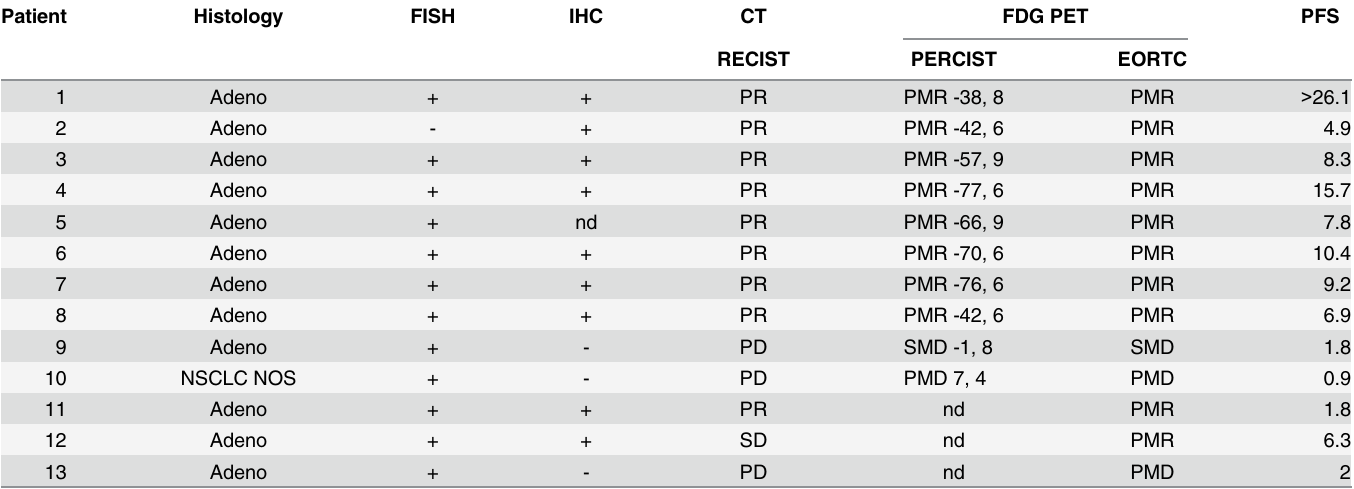
Table 2. Baseline 18 F-FDG PET and CT tumor response measurements with PERCIST and EORTC criteria and progression-free survival per patient with ALK positive